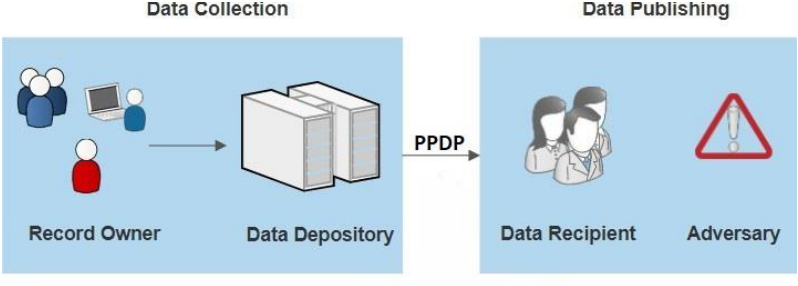
Fig. 1. Overview of PPDP